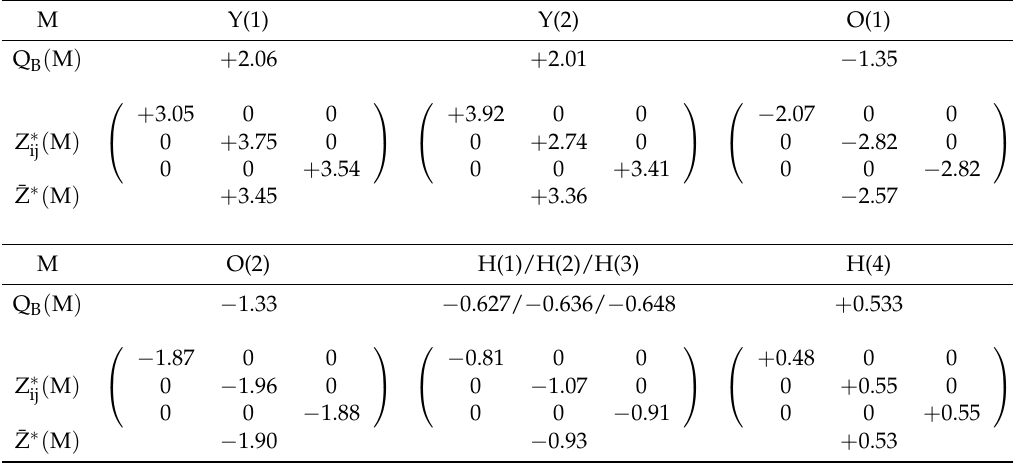
is the matrix of the Born dynamical ij